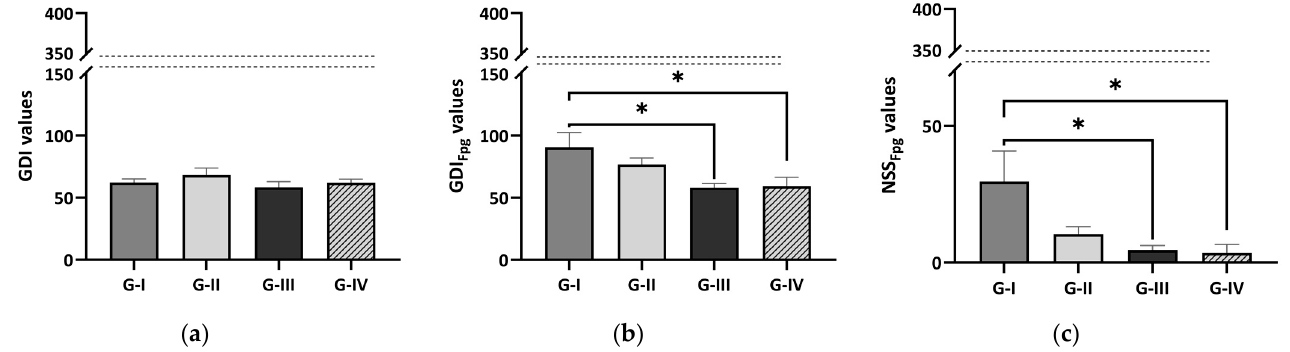
Figure 5. Genetic damage index values (mean ± SE and expressed as arbitrary units) determined by the comet assay, corresponding to untreated slides ( a ) and slides treated ( b ) with Fpg and the resulting NSS Fpg ( c ). * Statistically significant differences ( p < 0.05).